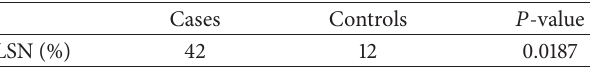
Table 2: Prevalence of Laryngeal Sensory Neuropathy (LSN) in cases and controls.